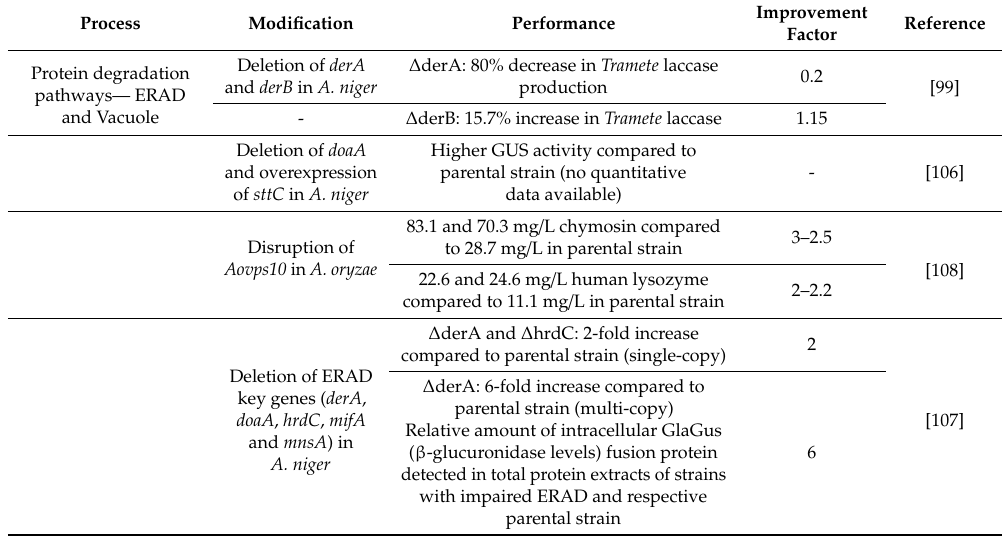
Table 8. Approaches for improving recombinant protein production through engineering protein degradation